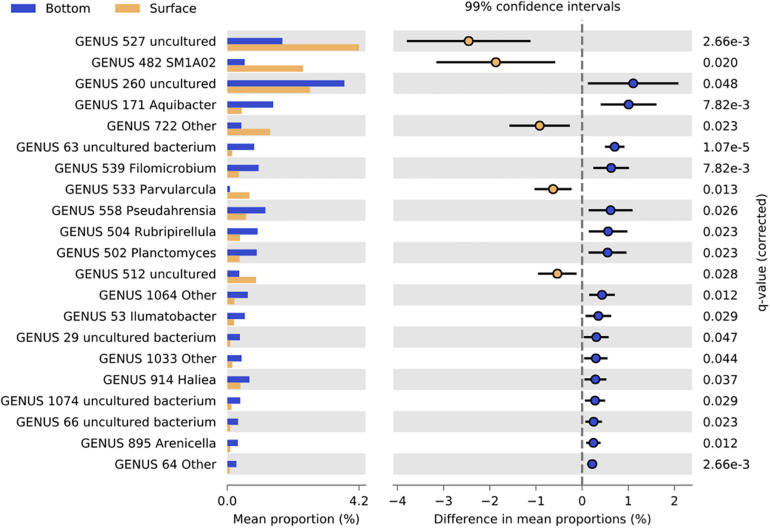
Bar graph representing relative proportions of significant genera in biofilms from surface (yellow) and bottom (blue) samples. Extended error bar plots showed pairwise comparison of significant genera proportions (Welch’s t-test; p < 0.01) between surface (yellow) and bottom (blue) samples. Corrected p-value is determined using Fisher’s exact test.